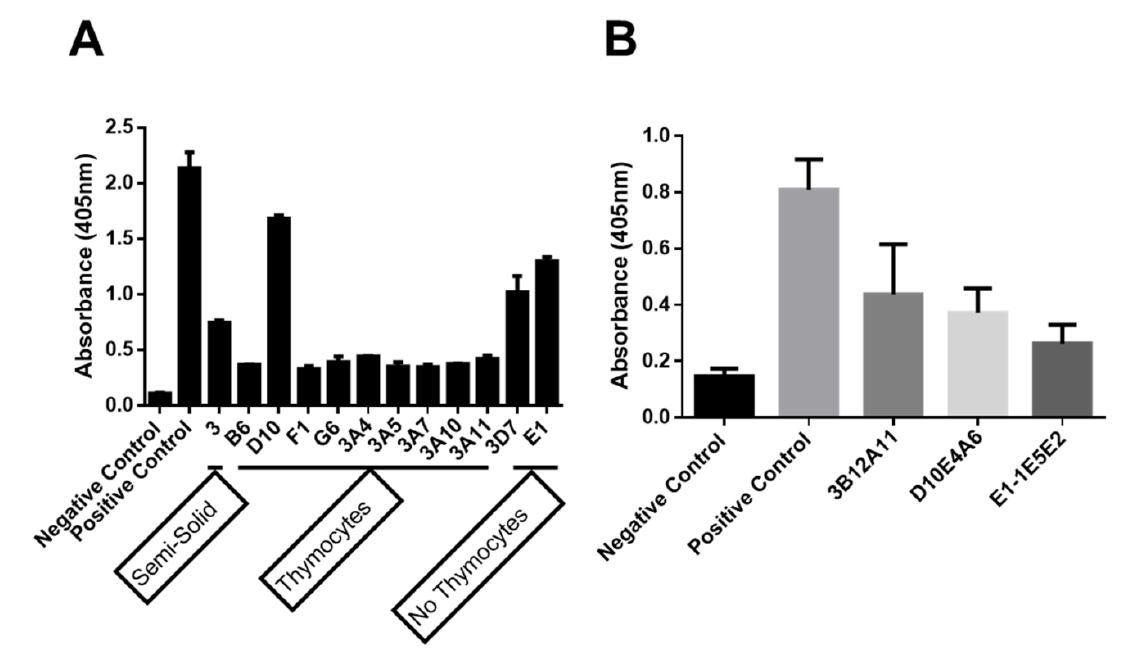
Figure 2. Development of mAbs against Myo1g. ( A ) ELISA results from the original plating after fusion. The addition of thymocytes as feeder cells increased the frequency of positive cells after screening. There were nine positive wells with thymocytes, two without thymocytes, and one in semi-solid media. ( B ) After two rounds of single cell cloning, three individual hybridomas producing high amounts of antibody against Myo1g, positive control (1:6400) and hybridomas (1:50), were established. Representative data from two independent experiments are shown as mean + SD of triplicate samples.